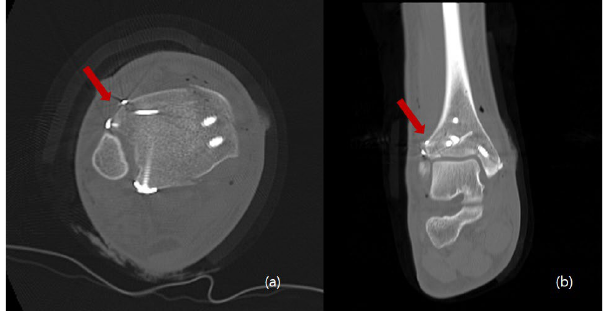
Figure 5. Postoperative axial ( a ) and coronal ( b ) computed tomography images show that the Chaput fracture exhibited good reduction, compression, and fixation (arrow). Table 1. Patient demographics and